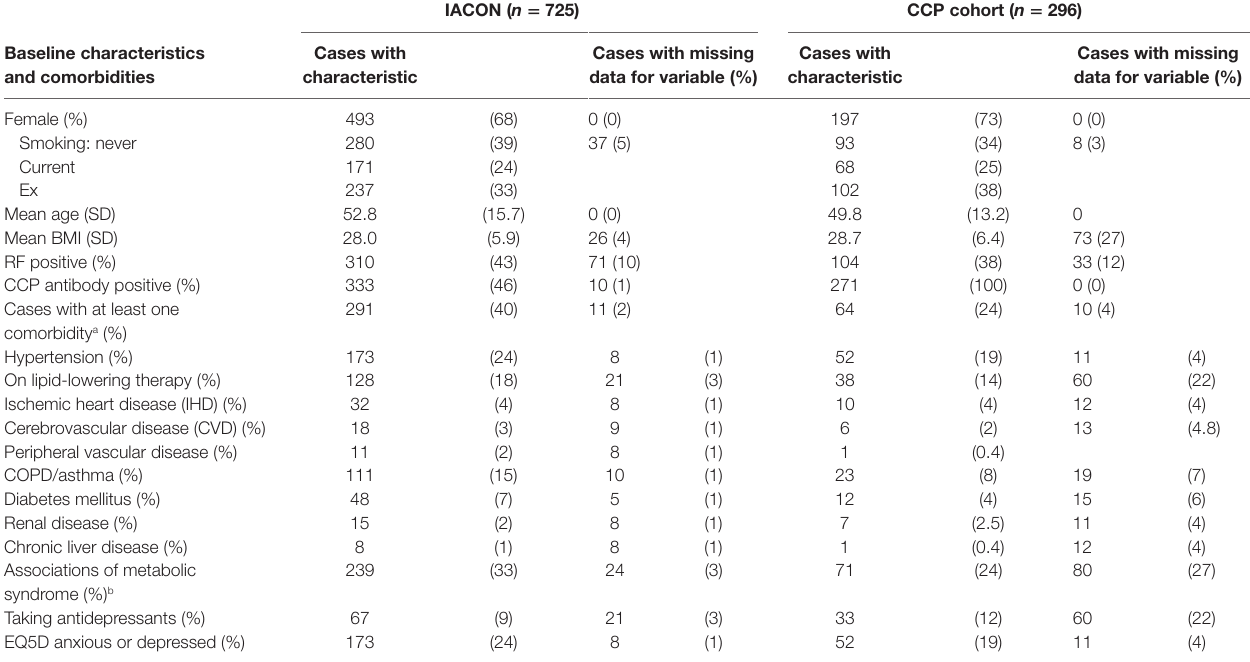
Table 1 | Baseline characteristics of the two cohorts.